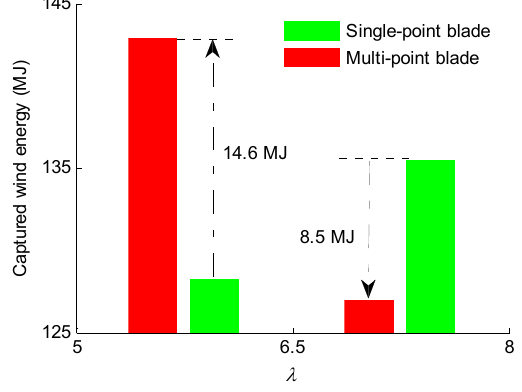
Figure 13. The captured wind energy corresponding to the interval U p 5,6.5 q and U p 6.5,8 q